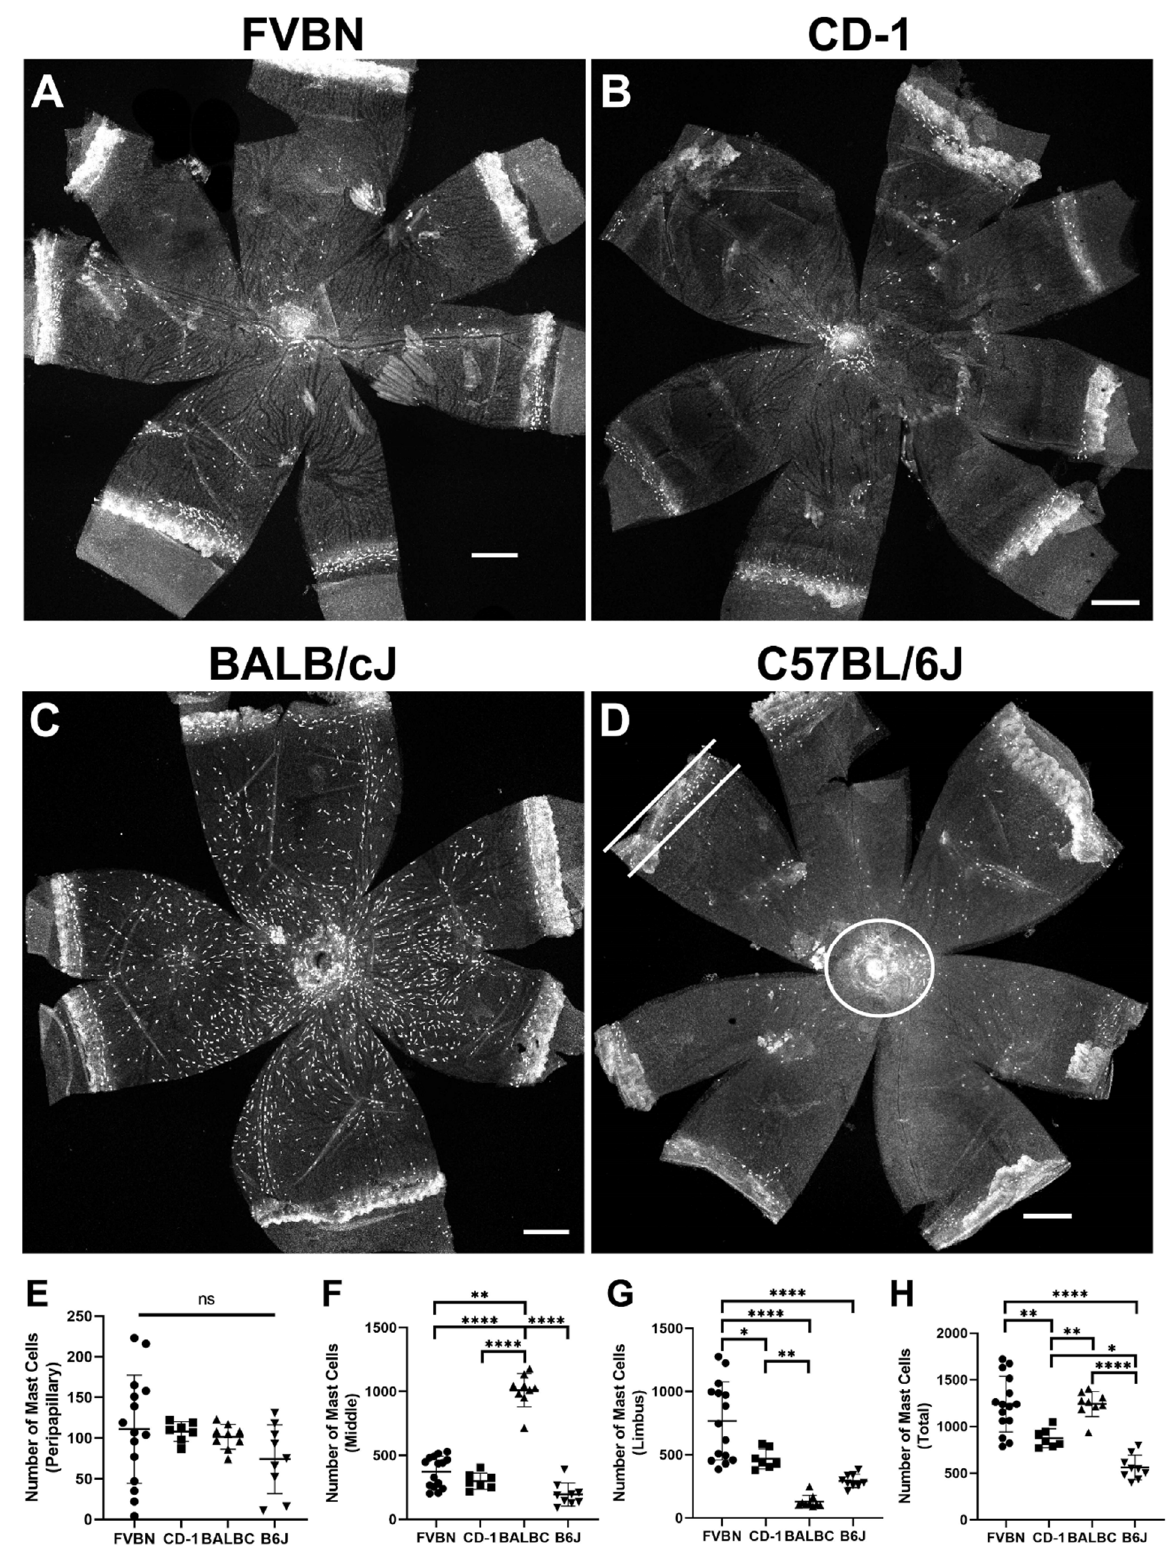
Figure 5. Visualization of mast cells in the choroid of albino and pigmented mice. Representative images showing the distribution of mast cells in choroidoscleral tissues from FVBN ( A ), CD-1 ( B ), BALB/cJ ( C ), and bleached C57BL/6J ( D ) mice. The counts of mast cells in the peripapillary ( E ), middle ( F ), limbus ( G ), and whole ( H ) choroid of the four examined strains of mice were determined and statistically analyzed. Each data point represents one choroid. A small number of mast cells